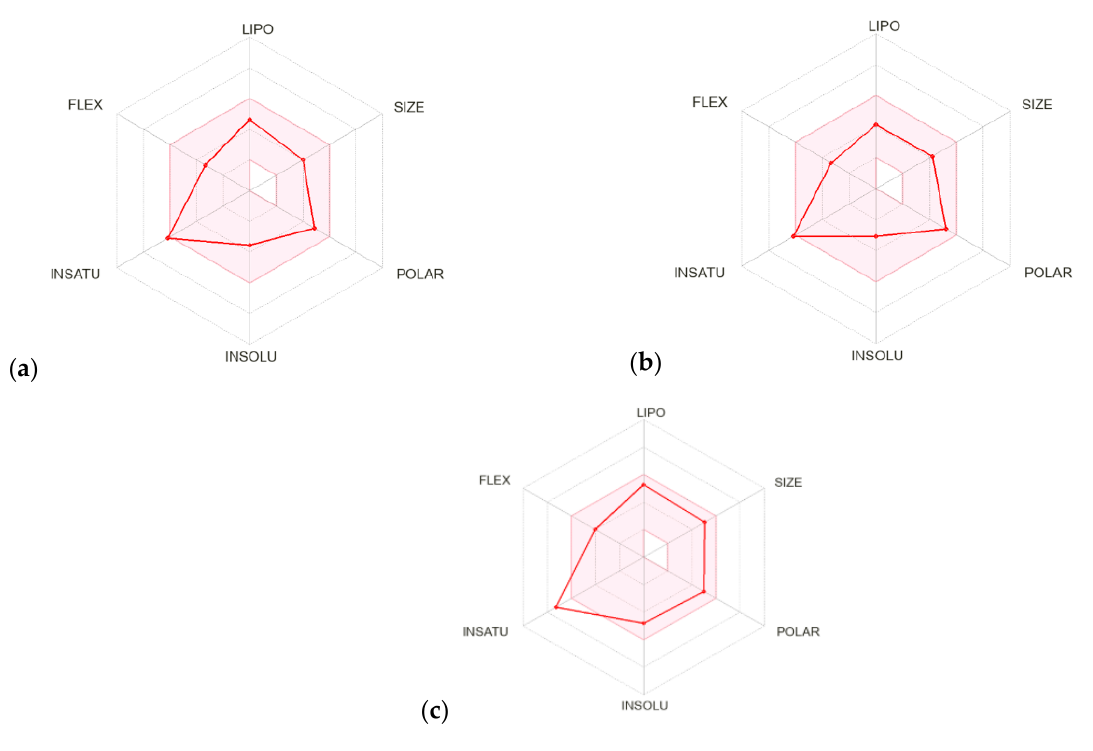
Figure 12. Bioavailability radar for ( a – c ).